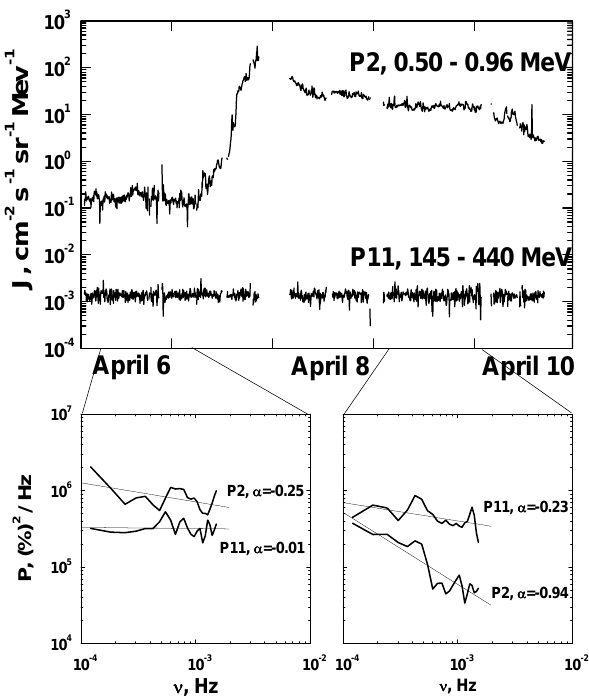
Fig. 3. An example of solar energetic particle event on 6–10 April 1995. Top: time profiles of CR fluxes measured by P2 and P11 channels of IMP-8/CPME. Bottom: Power spectra before (6 April, 04:21–7 April, 04:15 UT) and during the event (9 April, 03:20–10 April, 03:15 UT).